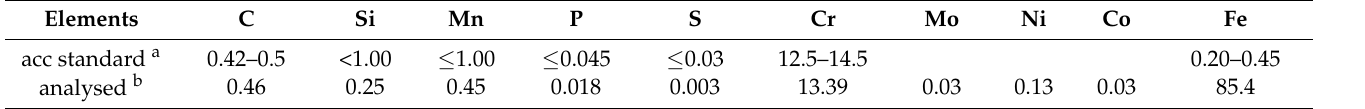
Table 3. Chemical composition of 1.4043 (X46Cr13, AISI 420C), in mass percent.